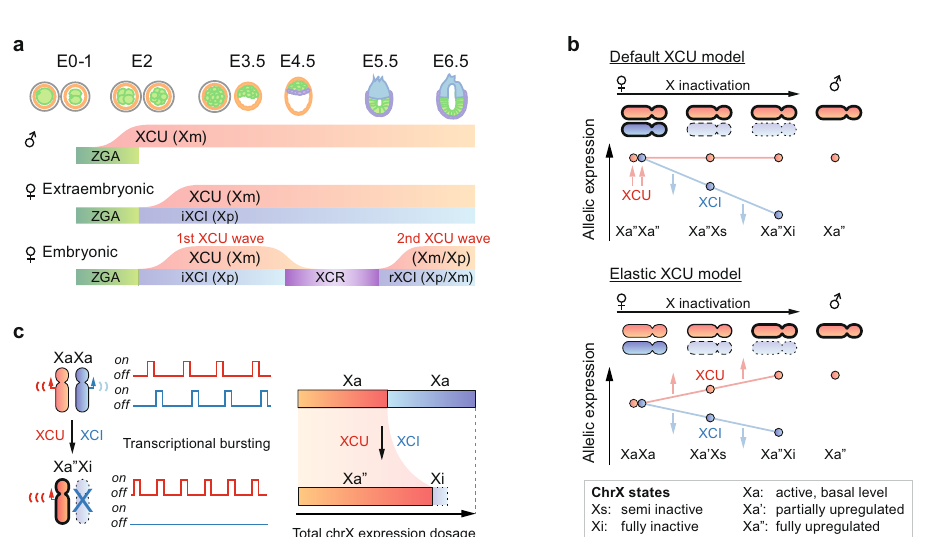
Fig. 5 A uni fi ed model of dosage compensation by X-upregulation and inactivation. a Overview of X-upregulation (XCU) timing and dynamics across mouse pre- and early postimplantation development in the two sexes and embryonic/extraembryonic lineages. zygotic genome activation (ZGA), imprinted X-chromosome inactivation (iXCI), X-chromosome reactivation (XCR), random X-chromosome inactivation (rXCI). b Previous model of dosage compensation ( “ Default XCU ” ), proposing that X-upregulation (XCU) is already present in female XaXa state after which X-inactivation (XCI) operates on one allele achieving balanced X-chromosome expression levels. Our allele-level data of XCU introduce a different model ( “ Elastic XCU ” ) in which XCU is established and tuned in relationship to the degree of XCI on the second allele. c As one allele is gradually silenced (Xi) in female cells, transcriptional burst frequency is increased on the second allele (Xa), making it hyperactive (Xa ” ). However, the single hyperactive allele (Xa ” ) does not fully reach the combined expression level of the two moderately active alleles in the female XaXa